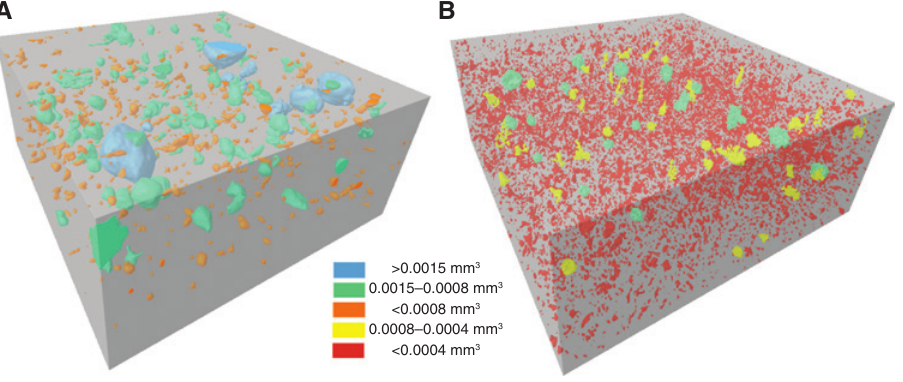
Figure 11: Three-dimensional surface models of the pore size distribution for (A) mortar and (B)